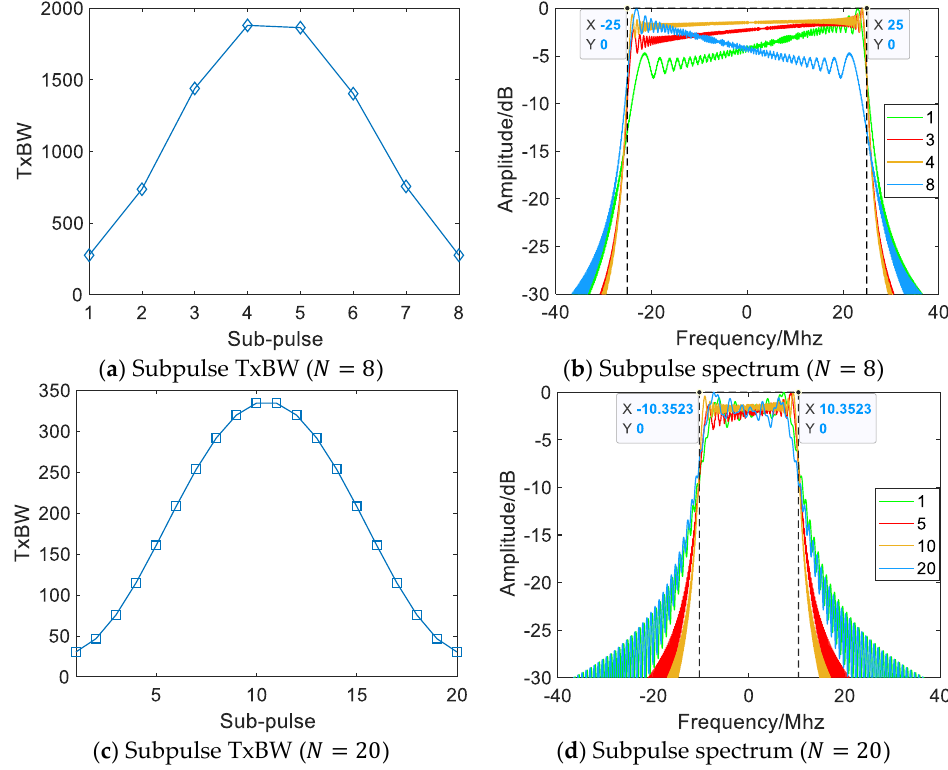
Figure 6. Subpulses at different TxBWs.